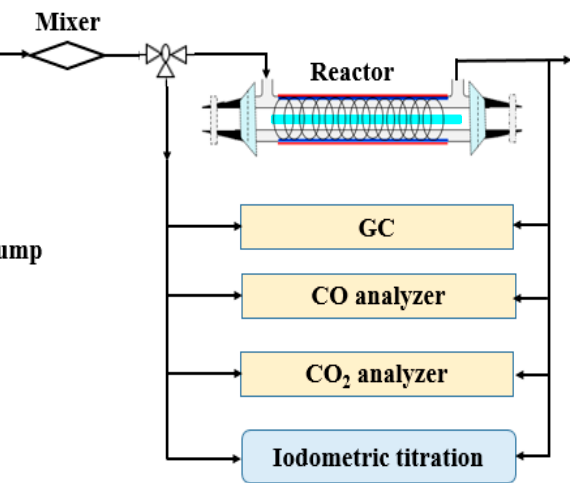
Figure 6. General schematic of the experimental setup. For the photocatalytic and combined process, the UV lamp was placed in the inner cylinder in order to obtain uniform irradiation on the catalyst surface. A detailed descrip- tion of polluted air stream generation is reported by [11]. Chlorobenzene (CB) was injected by an infusion syringe pump (3 µ L/h) to obtain 13 mg/m 3 concentration in 4.166 mL/min total flow